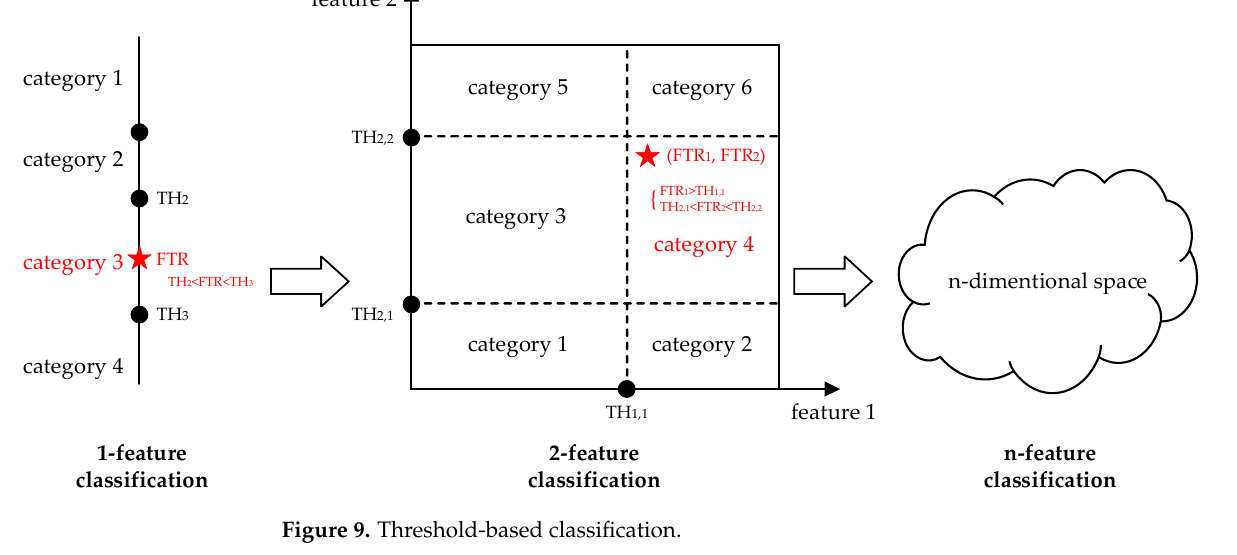
Figure 9. Threshold-based classification.